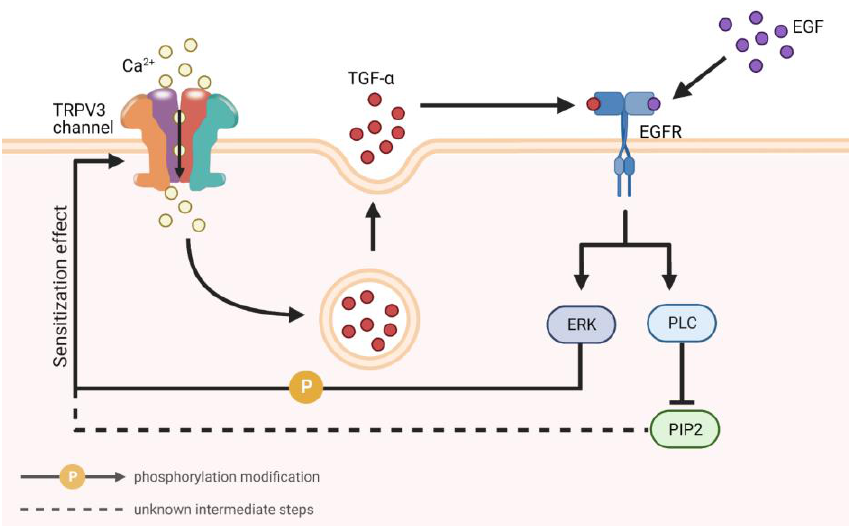
Figure 4. Positive feedback activation of TRPV3 and EGFR. The opening of activated TRPV3 channels for Ca 2+ influx leads to a surge in intracellular calcium signaling, which promotes TGF- α release. TGF- α and EGF in turn activate their receptor EGFR, which then activates ERK and PLC. ERK sensitizes TRPV3 by phosphorylation modification and PLC by hydrolyzing PIP2. TRPV3 in the sensitized state is more easily activated by stimuli. In a word, TRPV3 and EGFR form a positive feedback activation pathway.